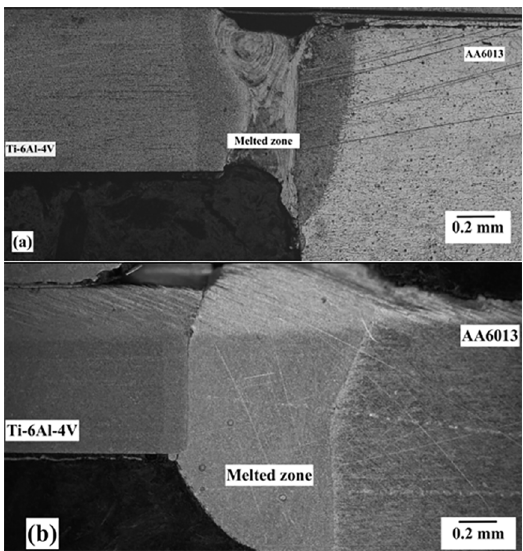
Figure 4. Ti/Al joint cross-sections with different laser positions, (a) interface line and (b) 0.3 mm toward Al alloy.